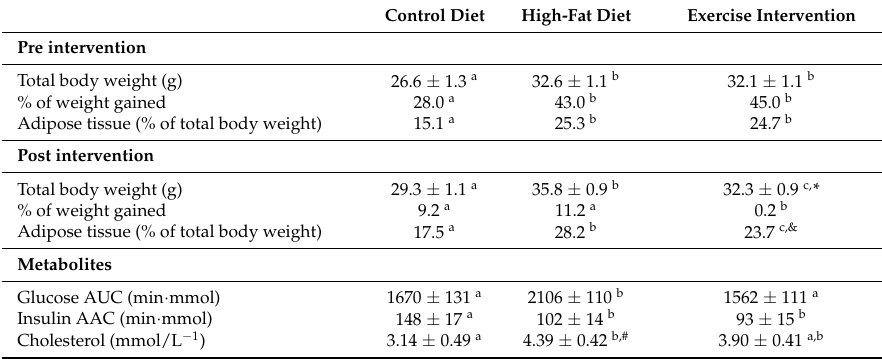
Table 1. Effect of founder high-fat diet (HFD) with exercise interventions on body composition and